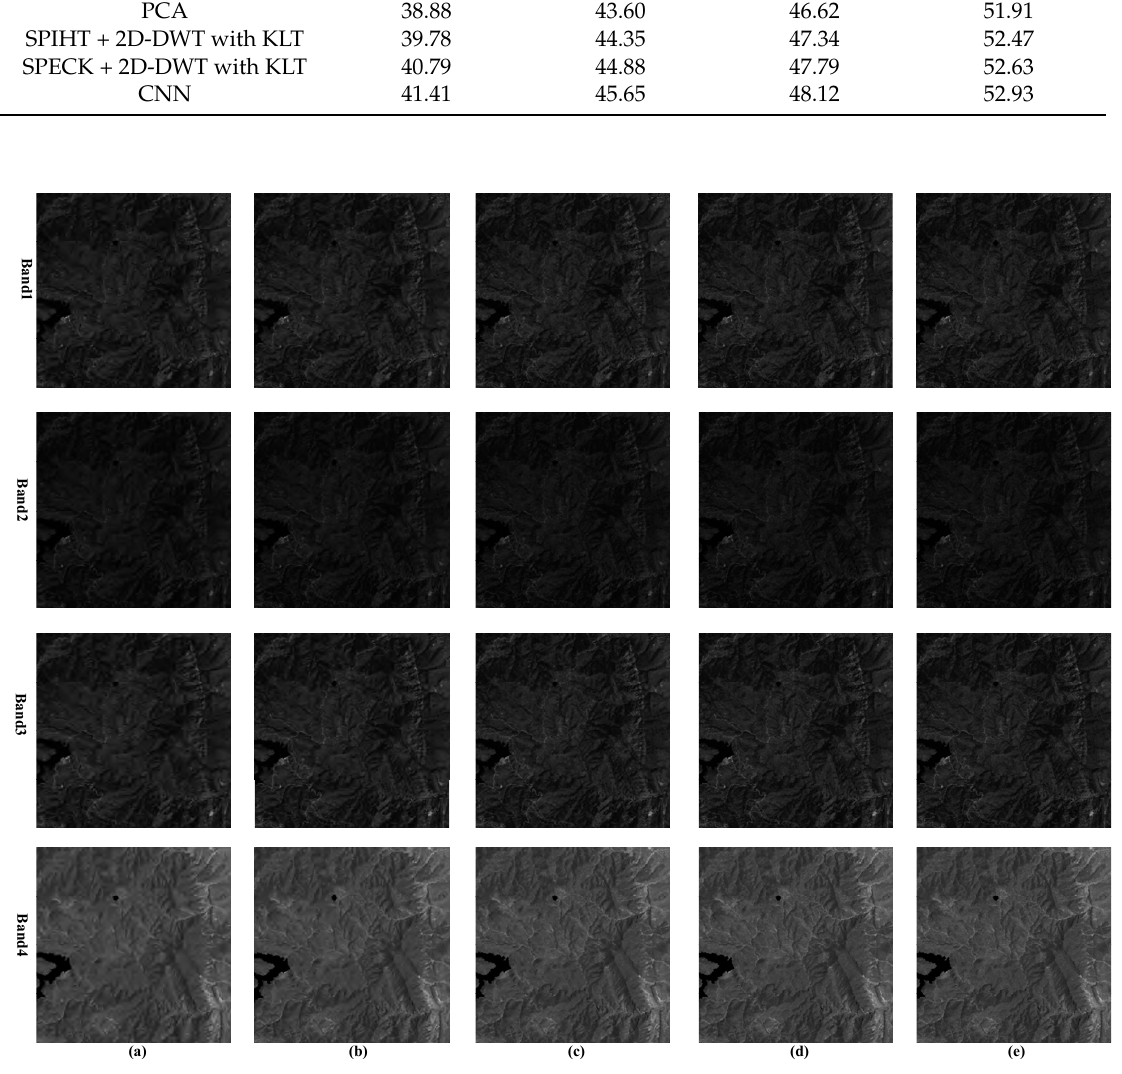
Figure 6. Reconstructed multispectral image at different bit-rates: ( a ) 0.25 bpp; ( b ) 0.5 bpp; ( c ) 1.0 bpp; ( d ) 2.0 bpp; and ( e ) original